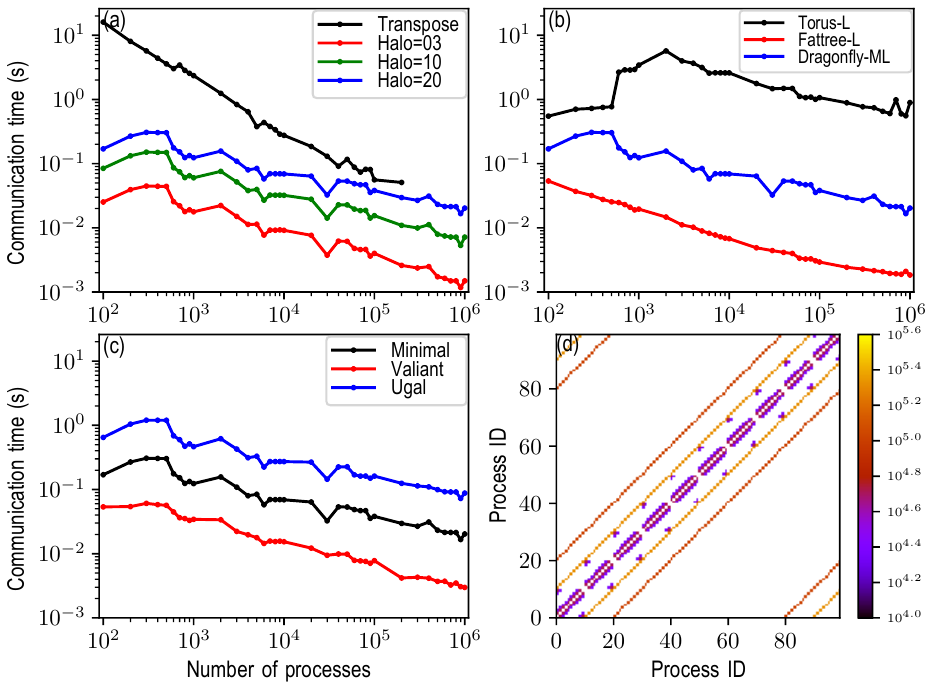
Figure 9. Panel (a) is the communication times of the halo exchange with a halo of 3 (red line), 10 (green line), and 20 (blue line) grid points, and the communication time of transposition for the spectral transform method is shown for comparison (black line). Panel (b) is the communication times of the halo exchange with a halo of 20 grid points for the topology of torus-L (black line), fattree-L (red line), and dragonfly-ML (blue line). Panel (c) is the communication times of the halo exchange with a halo of 20 grid points for the routing algorithm of minimal (black line), valiant (red line), and ugal (blue line). Panel (d) illustrates the communication pattern of the halo exchange with a wide halo. The circle markers in (a) – (c) indicate the numbers of processes of the corresponding